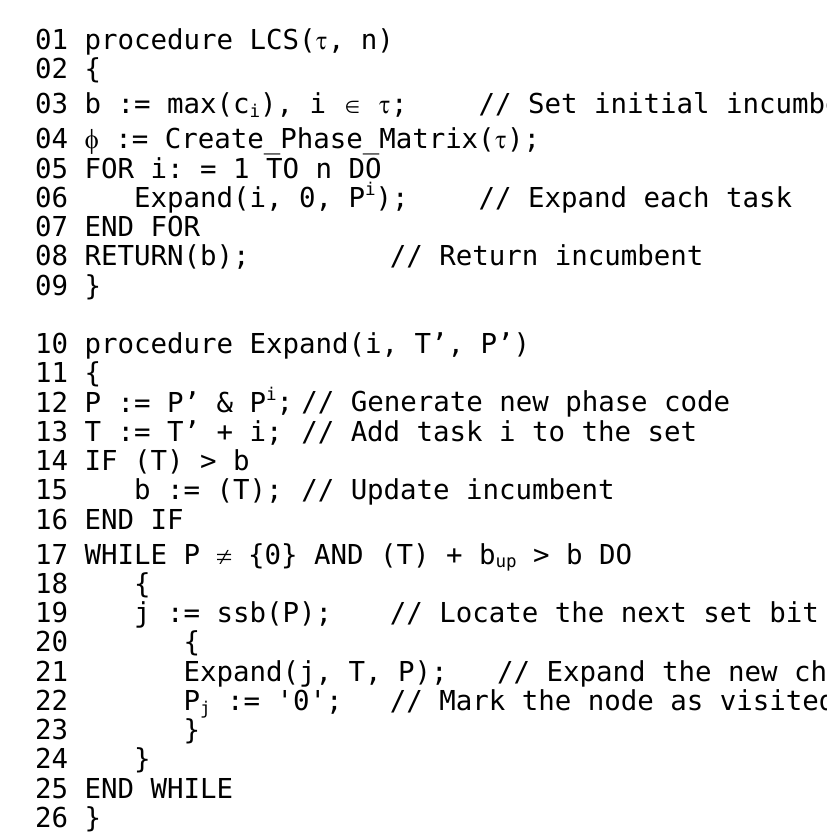
Figure 5. LCS algorithm, in